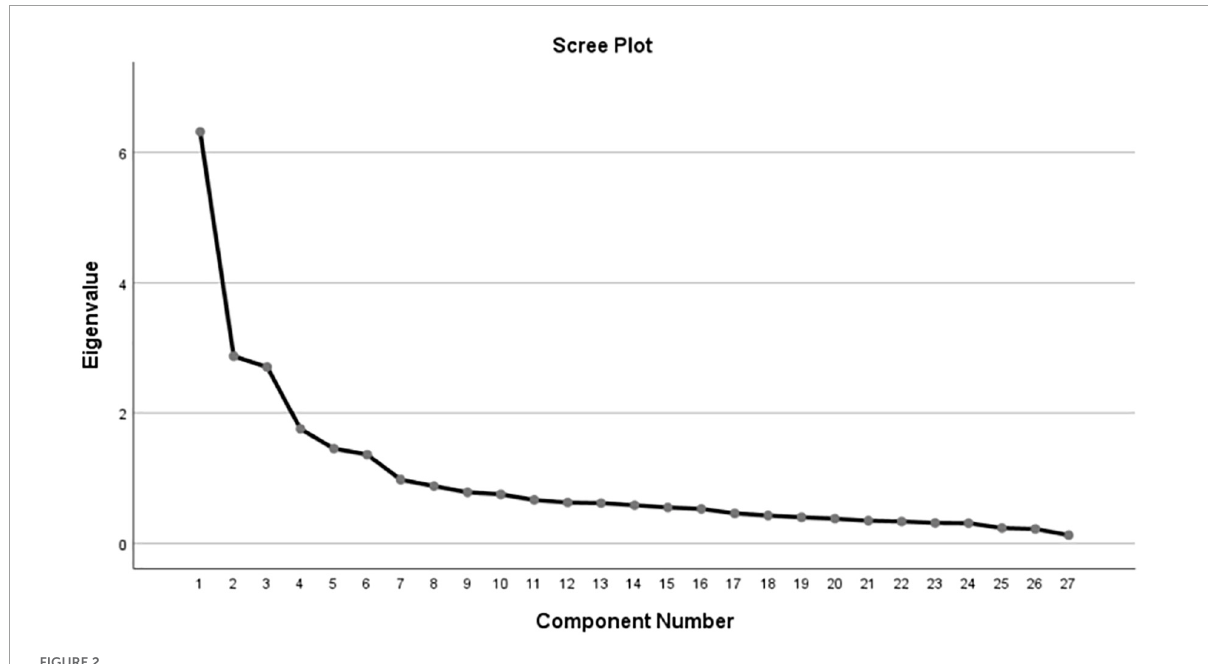
FIGURE2 The scree